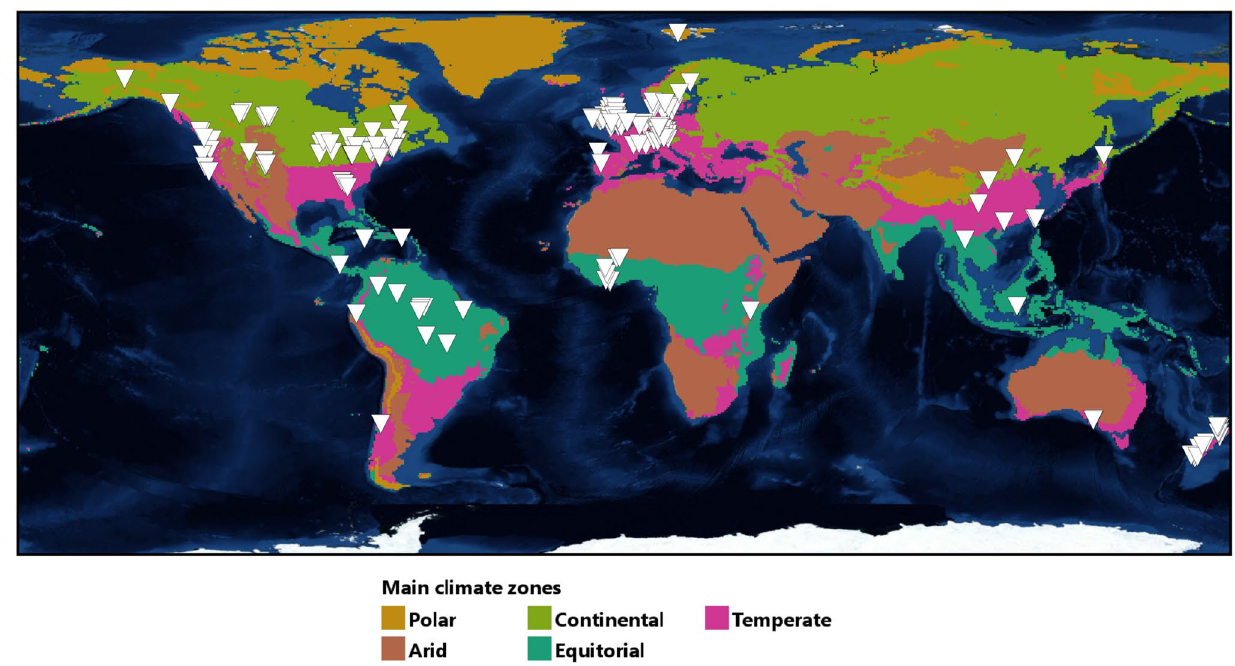
Fig. 1 Sampling sites reported in the database, distributed over main Köppen–Geiger climate zones [54]